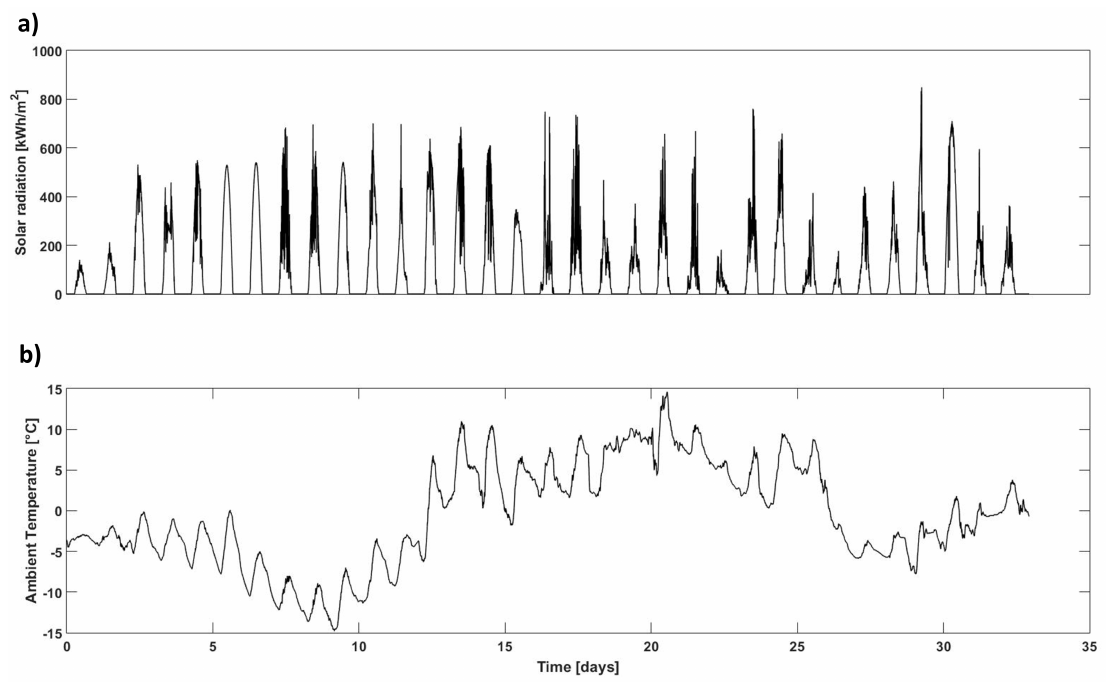
Figure 7. ( a ) Ambient temperature; and ( b ) solar radiation measured at the Wüstenrot pilot site